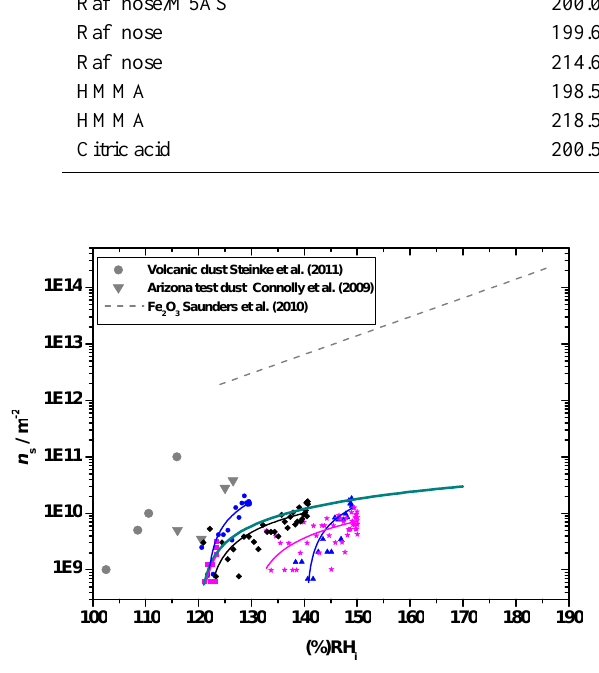
Fig. 11. A comparison of n s for glassy aerosols from this study and other IN species (see Fig. 8 legend for symbol details). Glassy citric acid aerosol n s is also shown (Murray et al., 2010a) (solid cyan line, see Fig. 10 caption for details). Linear fits to the data from this study are shown in the corresponding colour. Volcanic dust at ∼ 225K, (grey circles) (Steinke et al., 2011), Arizona test dust (ATD) at 238– 248K (grey downwards pointing triangles) (Connolly et al., 2009) (note that these are revised figures for ATD, based on a re-analysis by Niemand et al., 2012) and a parameterisation of n s for iron oxide nanoparticles at 190 K (grey dashed line) (Saunders et al., 2010) are shown. The parameters to the fits to n s vs. RH i for all of the glassy aerosols shown in this figure (solid lines) are included in Table